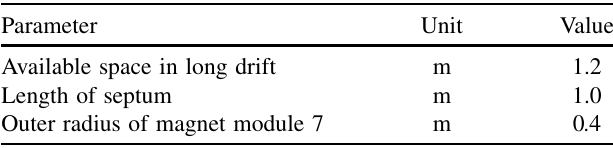
TABLE XXIII. Geometrical constraints of the septum magnet. Parameter